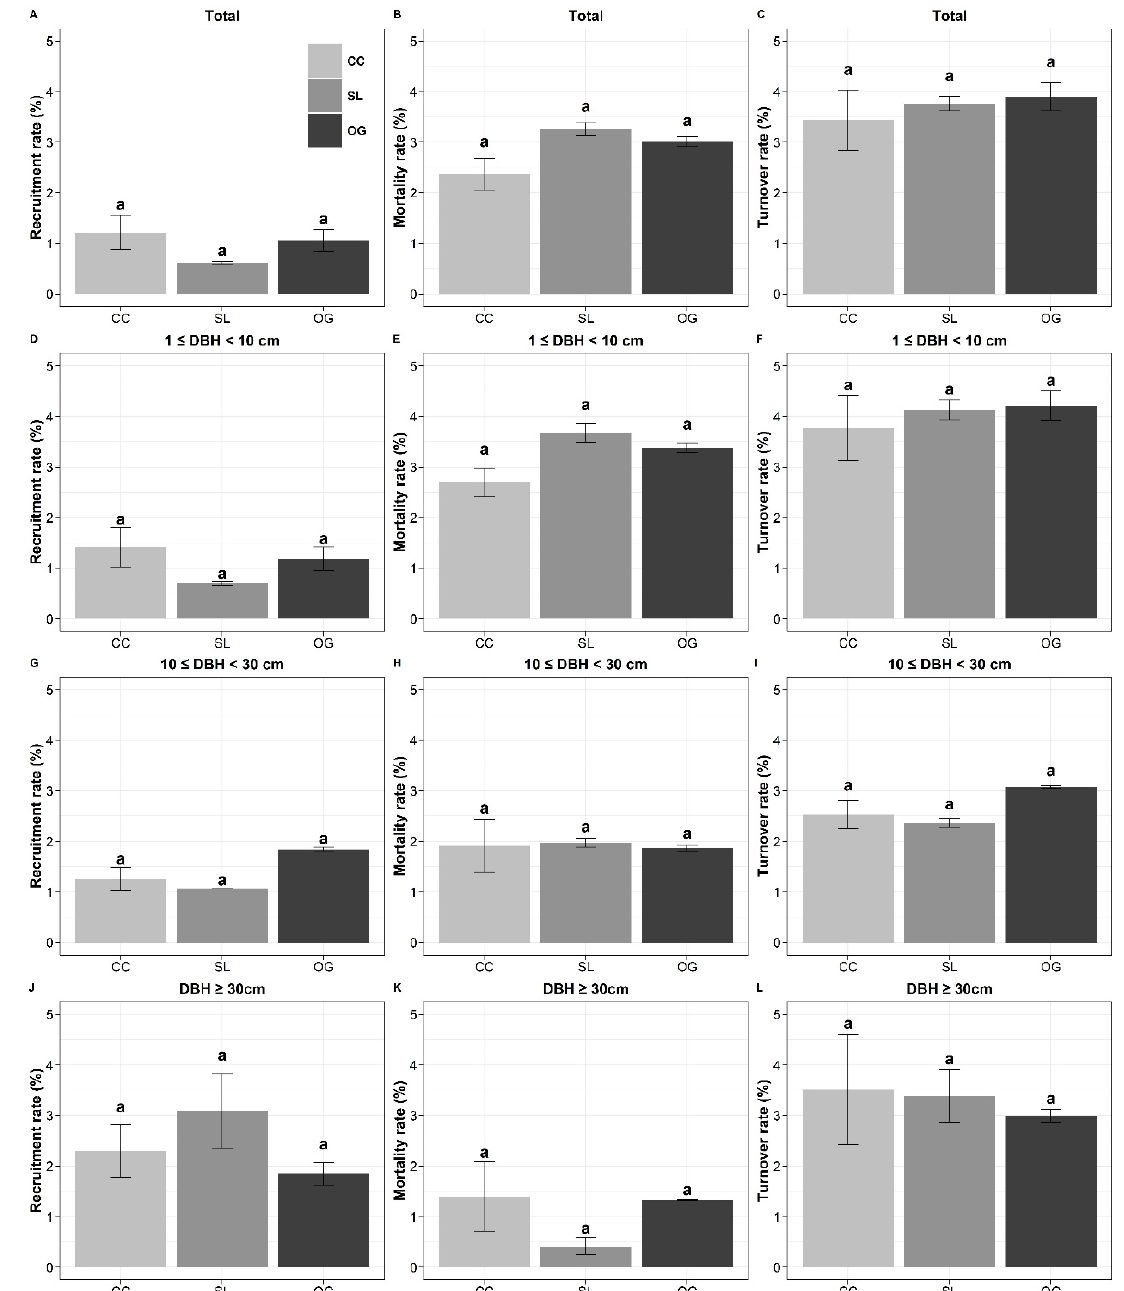
Figure 1. Variations in recruitment rates, mortality rates and turnover rates of abundance among forests after three disturbances (clear-cutting, CC; selectively logged, SL; old-growth forests, OG) for the total community ( A – C ), small trees (1 cm ≤ DBH < 10 cm, D – F ), medium trees (10 cm ≤ DBH < 30 cm, G – I ) and large trees (DBH ≥ 30 cm, J – L ). DBH, diameter at breast height. Different lowercase letters indicated significant differences between three disturbances at p < 0.05 according to ANOVA and HSD test.